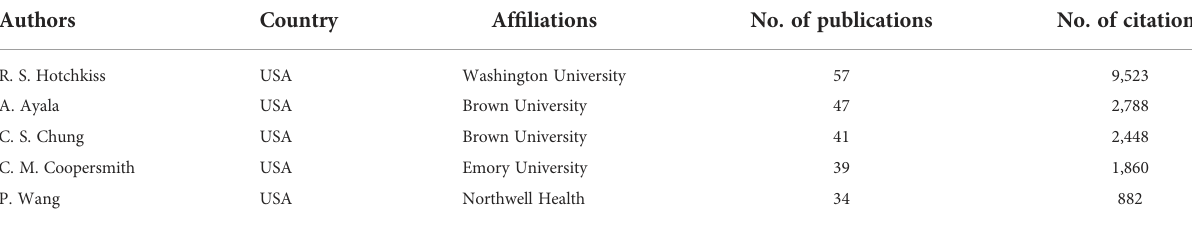
TABLE 1 Top 5 authors with most publications in research scope of sepsis and programmed cell